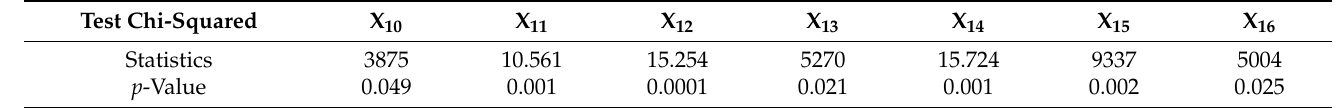
Table 11. “Macroeconomic heterogeneity”—Kruskal–Wallis test